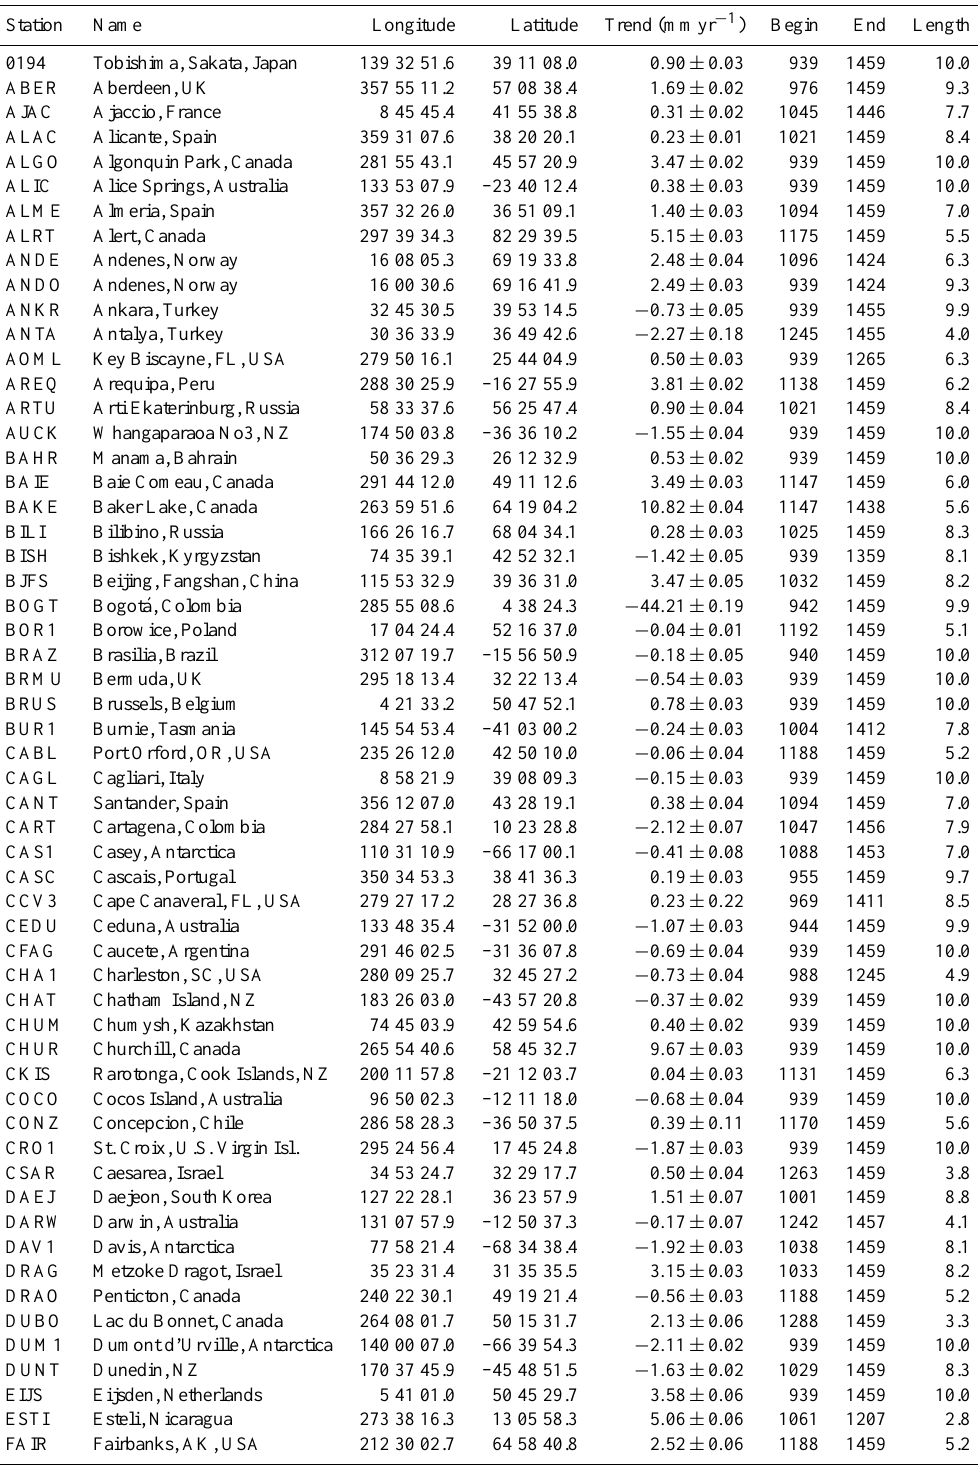
Table 2. Linear height trends at GPS stations. The table contains all stations from the TIGA reprocessing campaign with time series longer than 2.5yr from which a reasonable linear trend could be determined. Time series that showed large gaps were left out, as were stations with obvious jumps or trend changes. Some of these examples are treated in Sect. 4. A seasonal trend was removed for all stations. Atmospheric corrections were not applied. The station longitude and latitude are expressed in degrees, arc minutes and arc seconds. The beginning and the end of the time series are given as the GPS week number. The length of the time series is provided in years. Station